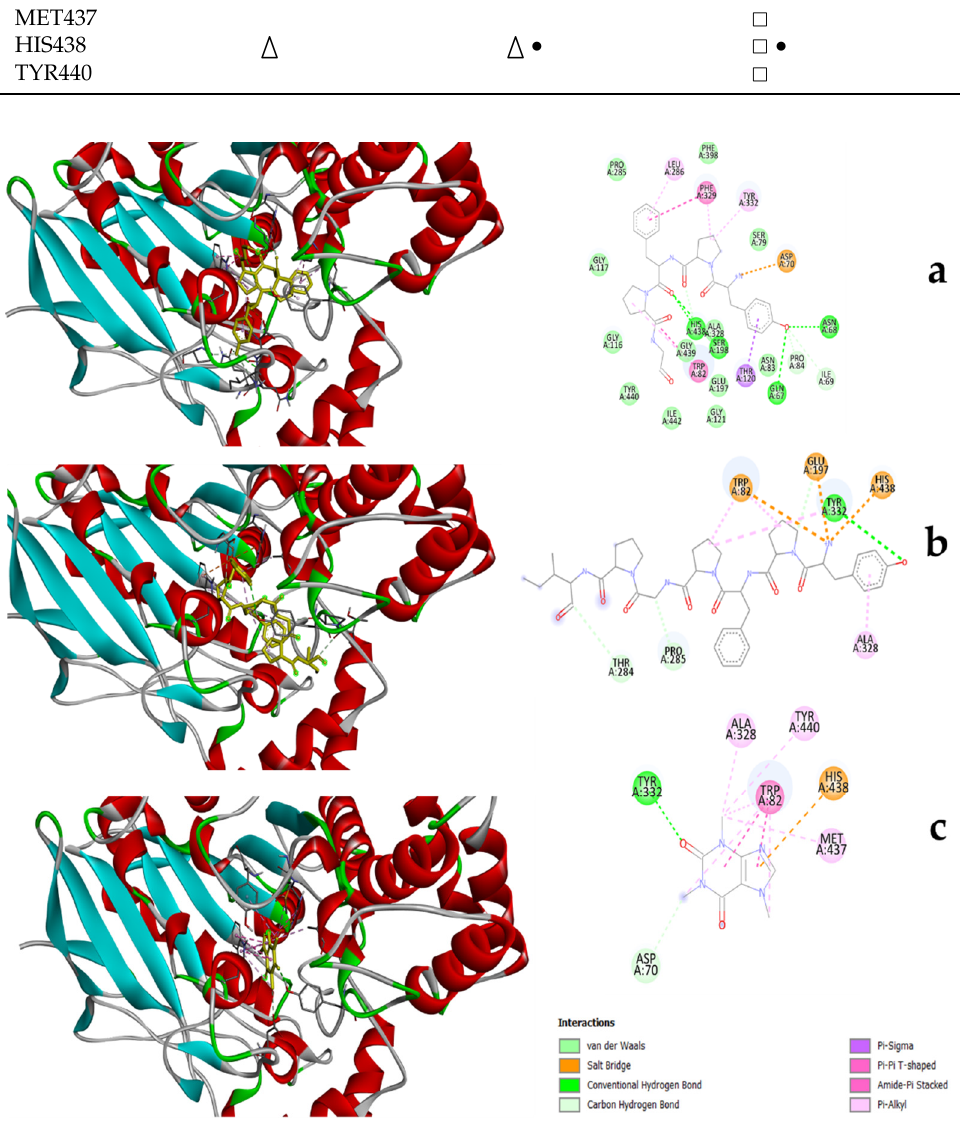
Figure 3. Predicted binding mode of opioid peptides to BChE (PDB: 4BBZ). ( a ) β b ‐ casomorphin ‐ 5; ( b ) β b ‐ casomorphin ‐ 7; and ( c ) caffeine. The best ‐ scored docking pose is shown.